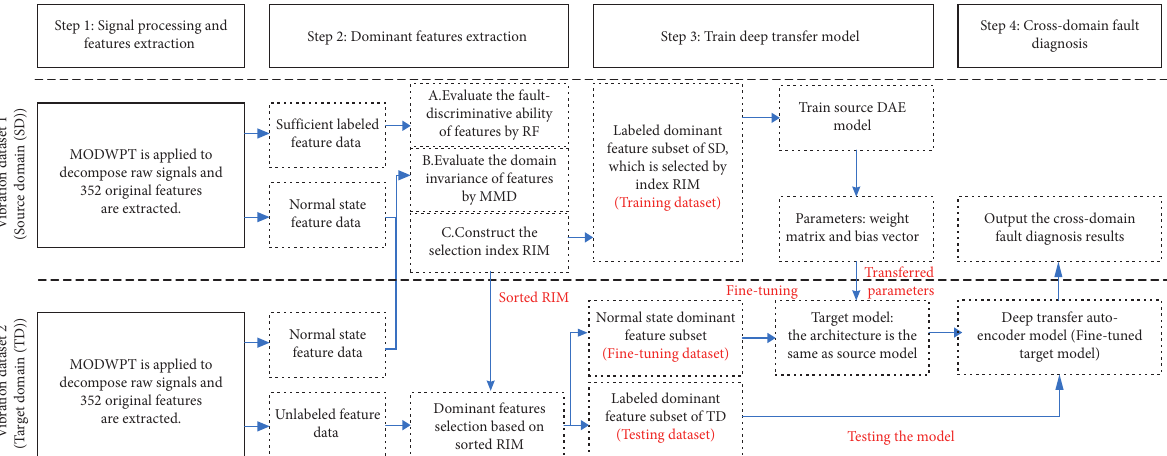
Figure 4: The proposed transferable fault diagnosis framework for rotating machinery across different operating